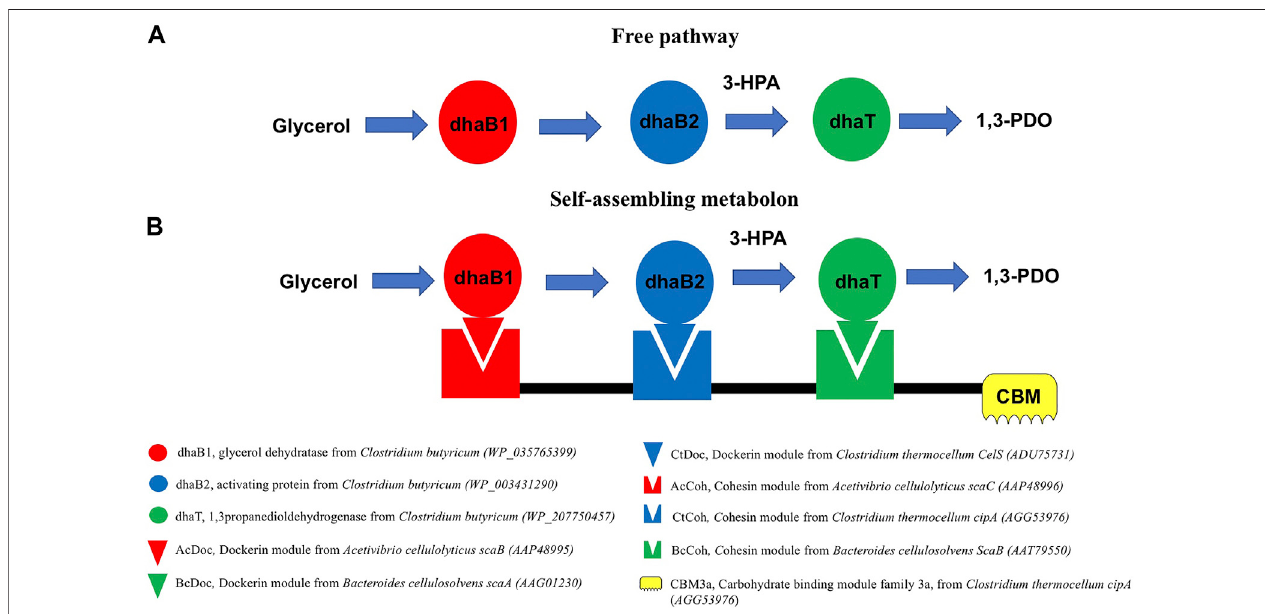
FIGURE 1 | Comparison of a traditional cell-free biocatalysis approach using puri fi ed enzymes and our self-assembling metabolon using an engineered protein scaffold for the conversion of glycerol to 1,3-PDO. In the self-assembling metabolon, the enzymes are expressed as protein fusions with a dockerin module speci fi cally